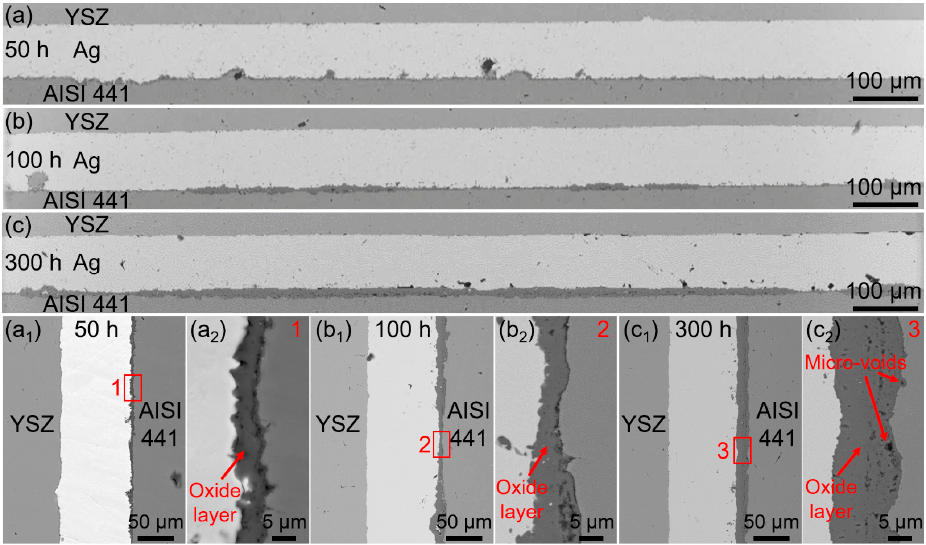
Figure 8. Overview of the SEM image of the joints after aging in air at 800 °C for ( a ) 50 h, ( b ) 100 h, and ( c ) 300 h, respectively. ( a 1 – c 1 ) are interfacial microstructure of joints, ( a 2 – c 2 ) are enlarged views at the AISI 441 interface).